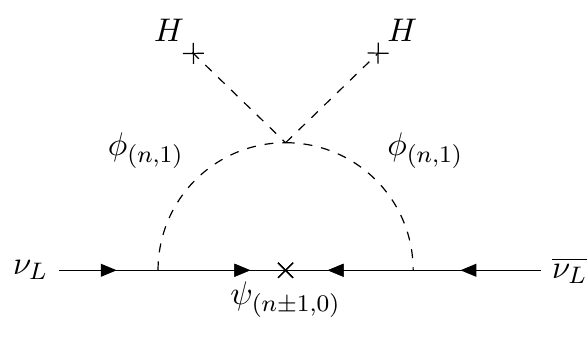
Figure 1 . Neutrino mass diagram resulting from model class